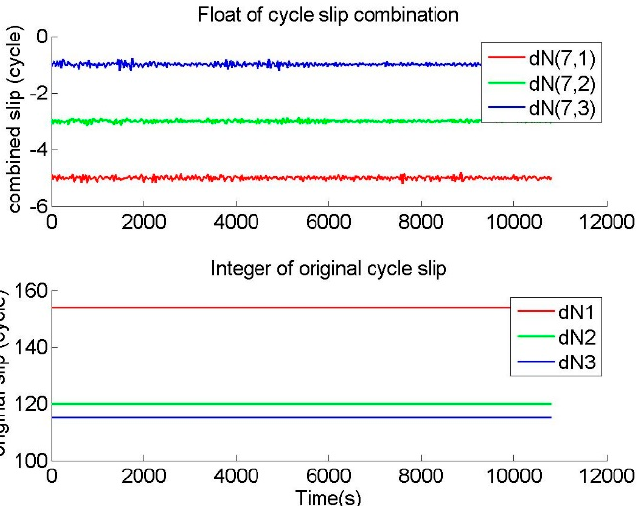
Figure 11. Repair results of cycle slip combinations and original cycle slips from GTCSR, where the phase data had the known cycle slips of (154,120,115) epoch by epoch on GPS satellite 10 at CUT0 station during the geomagnetic storm that started from UTC 2016/05/08 00:00:00.